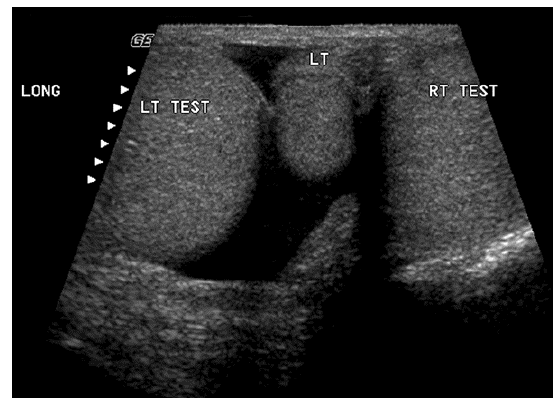
FIGURE 1 . Scrotal ultrasound demonstrating supernumerary testis.